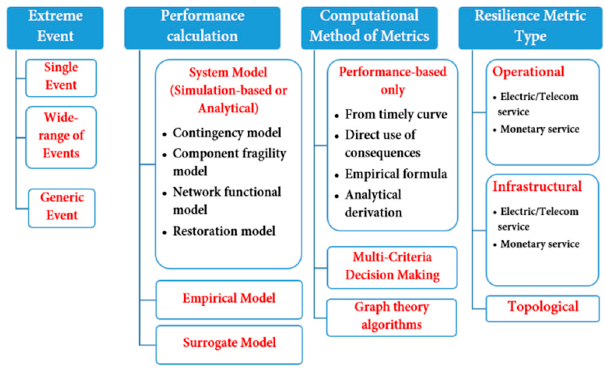
Figure 2. Proposed classification for resilience evaluation frameworks.